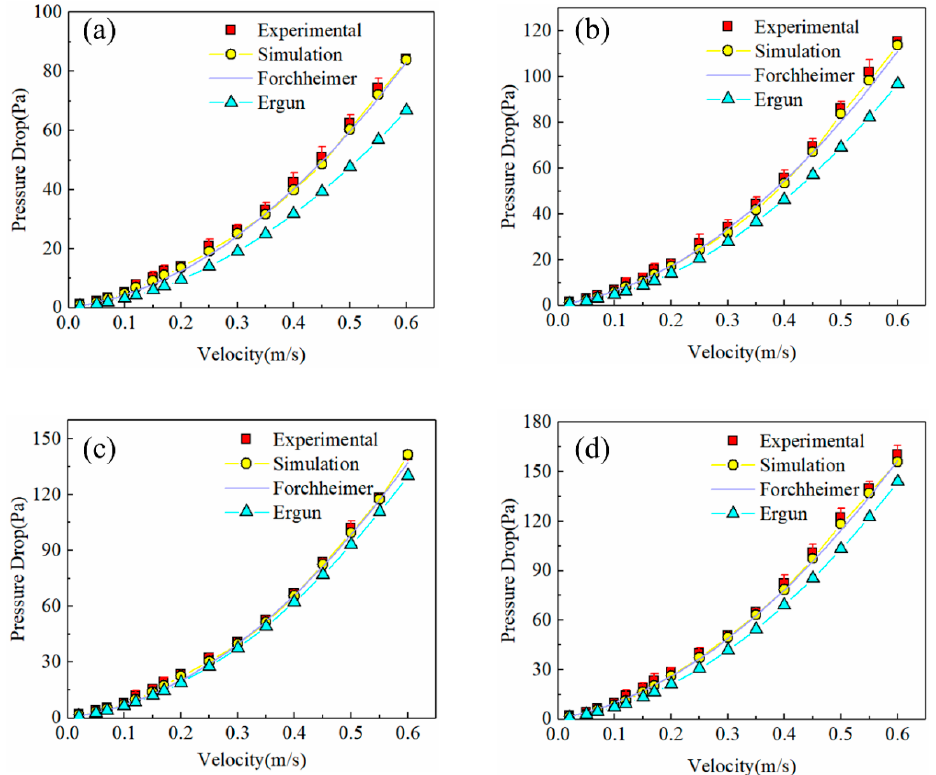
Figure 11. Comparison results of soybean pressure drop at different vertical pressures: ( a ) 0 kPa ( b ) 50 kPa ( c ) 150 kPa ( d ) 250 kPa. ( b ) 50 kPa ( c ) 150 kPa ( d ) 250